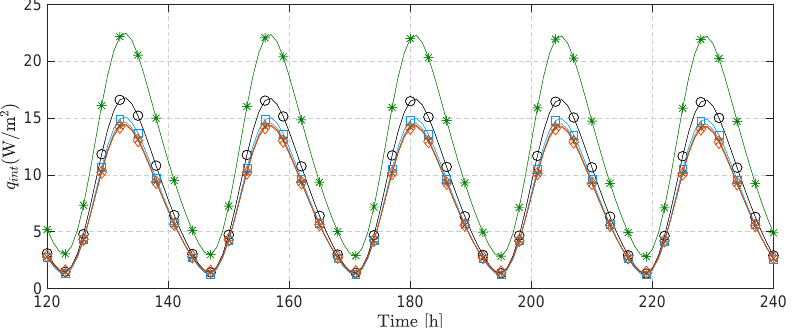
Figure 4. Facade surface temperature on the brick wall with canopy, T sw , over time—sensitivity to wind speed, v : ( ∗ ) 0.0 m/s; ( ◦ ) 0.5 m/s; ( (cid:3) ) 1.5 m/s; (+) 2.5 m/s; ( × ) 3.5 m/s; ( (cid:5) ) 4.5 m/s.